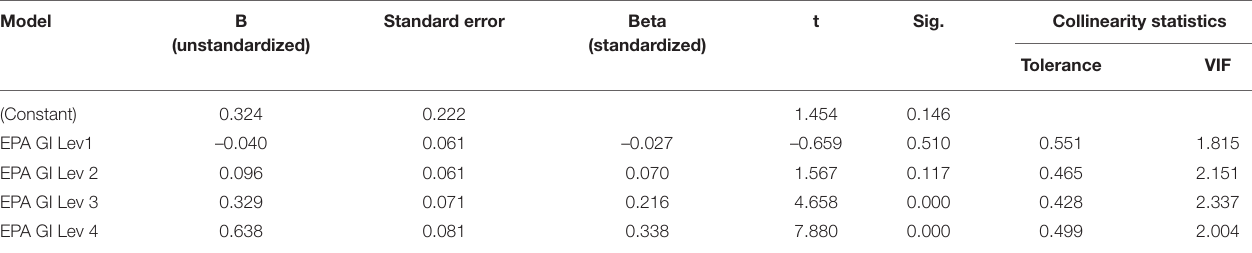
TABLE 2 | OLS regression for GI EPA 2 a .